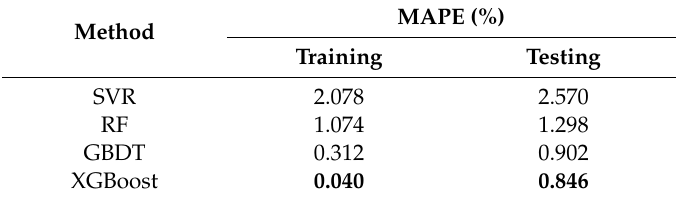
Table 4. Comparison of prediction result via di ff erent machine learning